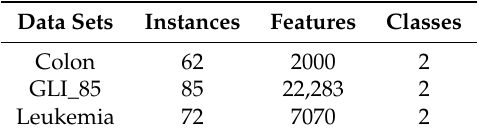
Table 1. Statistics of three gene expression